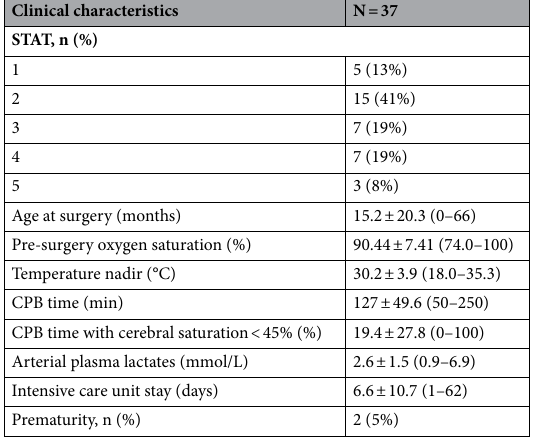
Table 1. Clinical characteristics of the CHD population. Continuous variables are expressed as mean ± standard deviations (range min–max). STAT: The Society of Thoracic Surgeons-European Association for Cardio-Thoracic Surgery score CPB: cardiopulmonary